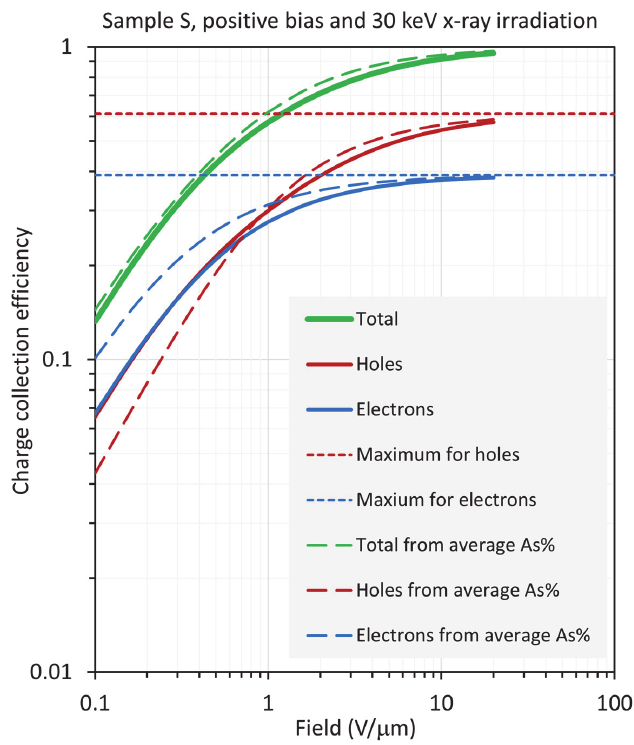
Figure 12. Log–log plot of the CE as a function of field for sample S (near worst case), biased positively and exposed to X-rays with a photon energy of 30 keV, so that δ / L =0.73.